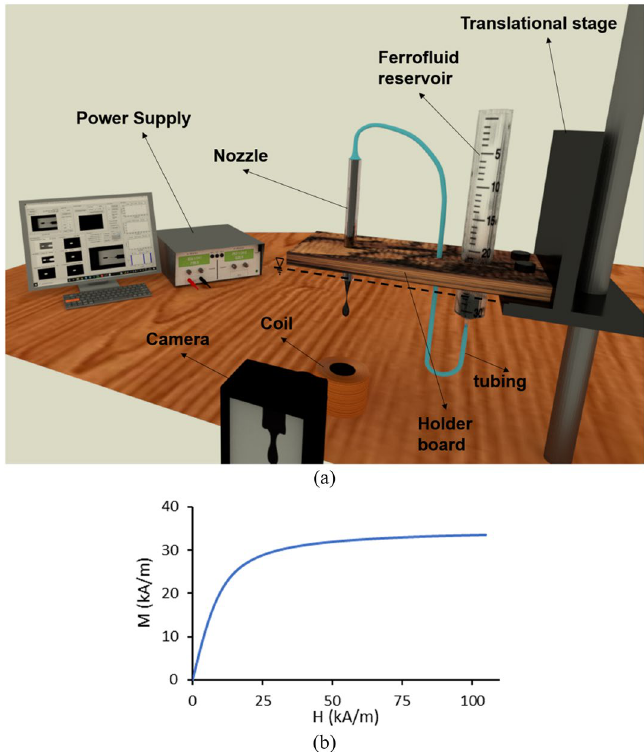
Figure 1. ( a ) Experimental setup, ( b ) magnetization versus magnetic field strength for